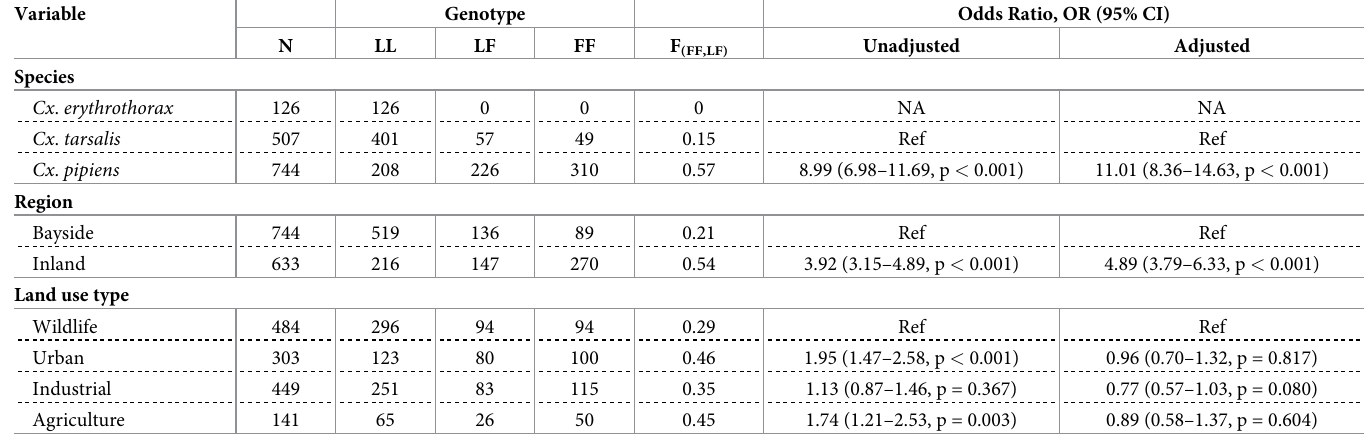
Table 5. Genotypes detected, F (FF,LF) , unadjusted and adjusted odds ratios among species, geographic region and land use type. Homozygous LL-1014 (LL), hetero- zygous LF-1014 (LF), homozygous FF-1014 (FF). Variable